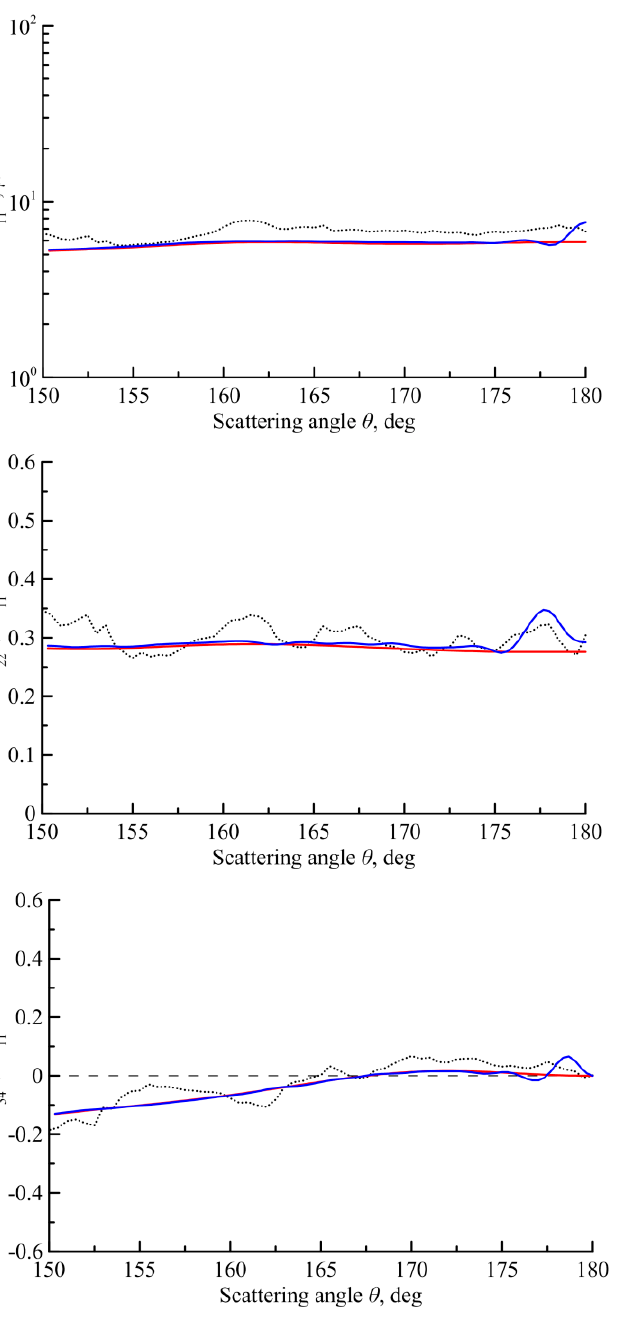
Figure 3. The scattering matrix for the shape 2 of Figure 1.